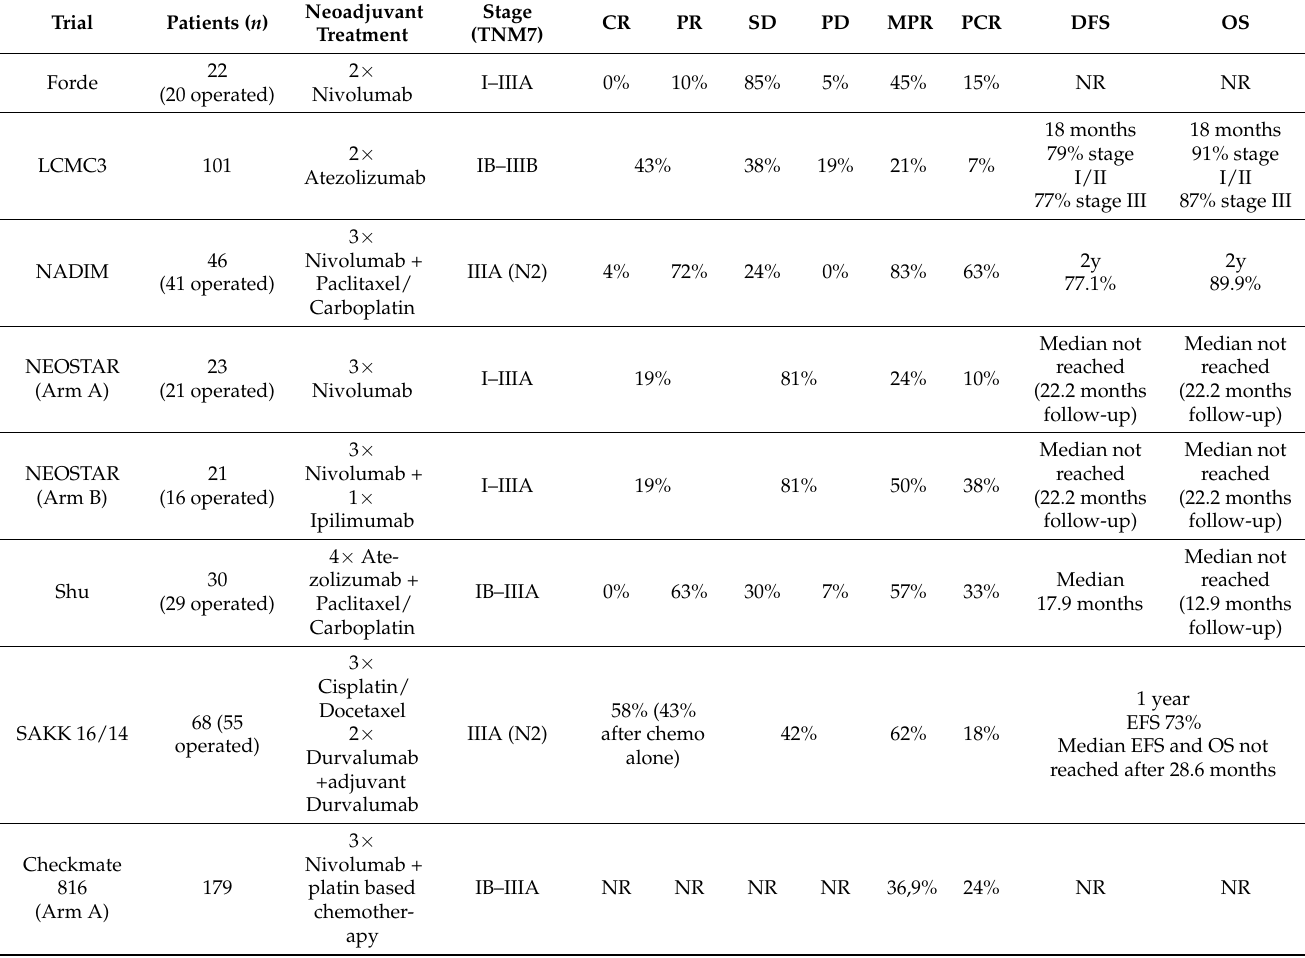
Table 1. Histopathologic response rates in neoadjuvant immunotherapy trials.